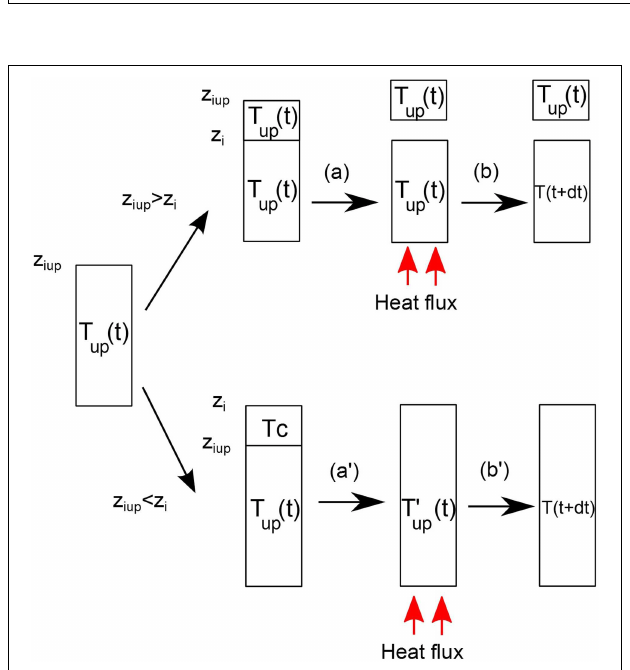
FIGURE 4 | Description of the boundary layer model.